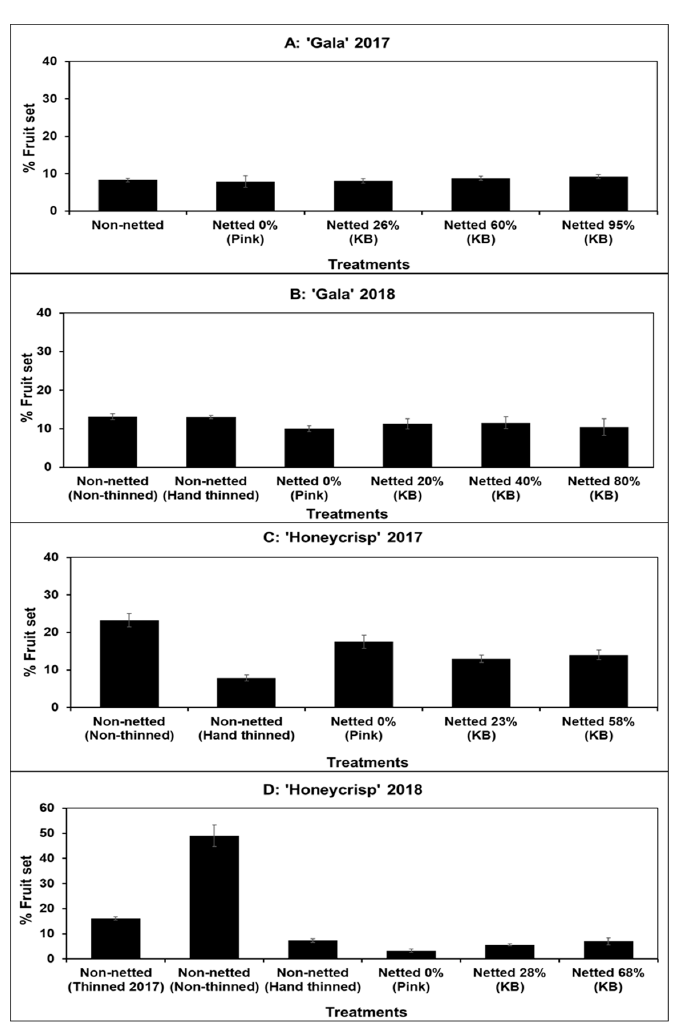
Figure 2. Effect of 2017 and 2018 netting treatments on average fruit set (%) of ‘Gala’ ( A , B ) and ‘Honeycrisp’ ( C , D ) limbs and whole trees, respectively. Vertical bars represent SE. Each treatment is the average of three replicates for ‘Gala’ and four replicates for ‘Honeycrisp’. Mean separation among treatments by Tukey HSD ( P < 0.05), whereby means associated with different letters are significantly different. (Pink) pink stage of bud development. (KB) king flower bloom.